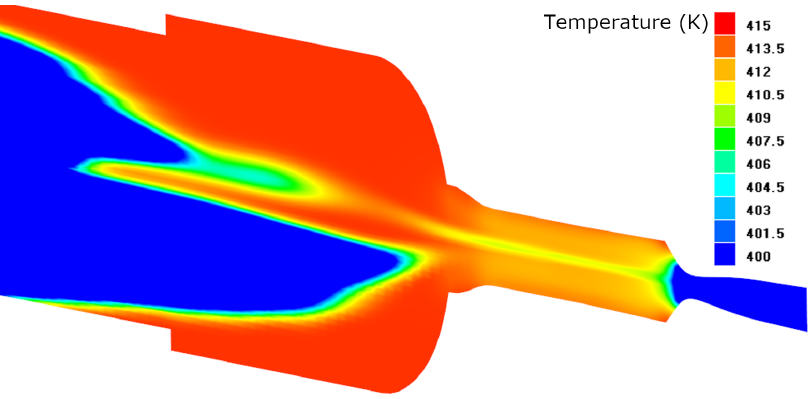
Figure 16. Example of hot-cold boundary distortion inside plenum during operation with back valves